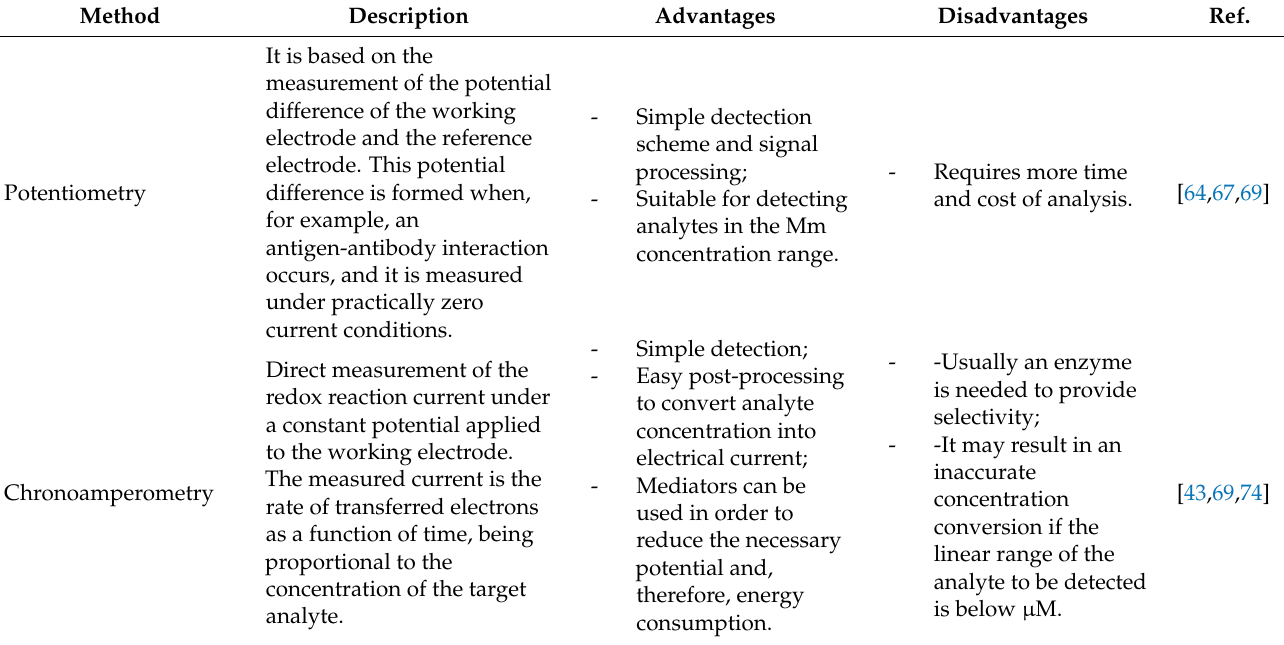
Table 3. Advantages and disadvantages of the electrochemical